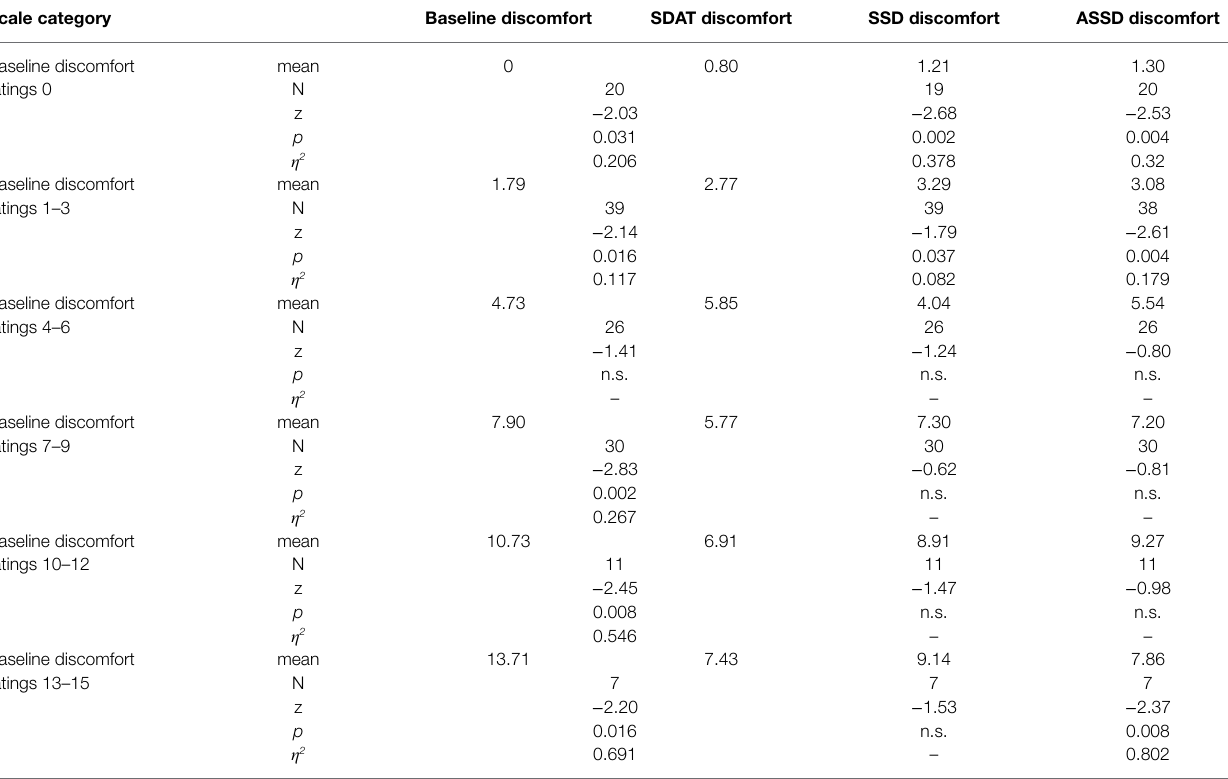
TABLE 3 | Exact Wilcoxon-Tests (one-sided) for discomfort rating differences between assisted and non-assisted rides by assistant system and by scale category of the baseline discomfort ratings. Scale category Baseline discomfort SDAT discomfort SSD discomfort ASSD discomfort Baseline discomfort ratings 0